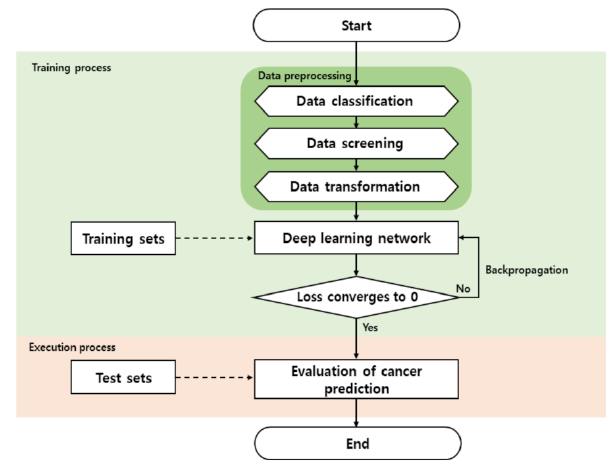
Figure 6. The overall flow chart of this study.